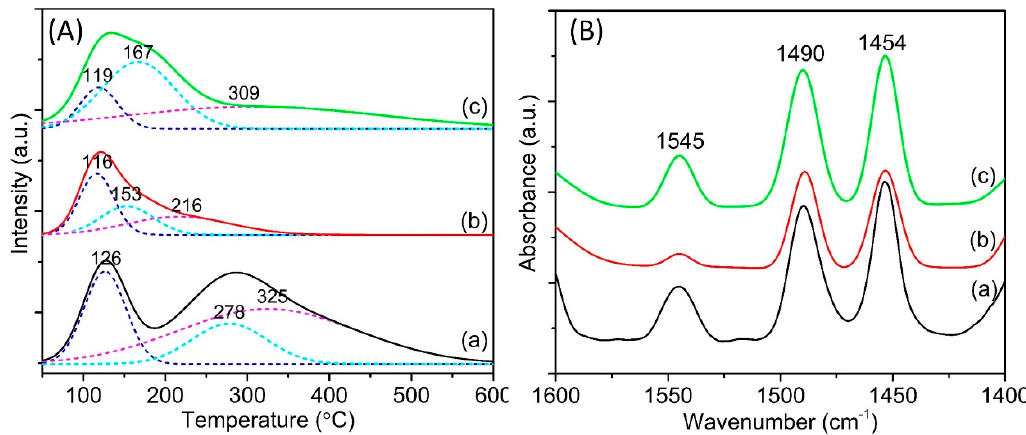
Figure 4. ( A ) TPD-NH 3 profiles and ( B ) pyridine-FTIR spectra of (a) Parent Y65, (b) IM-Y65, and (c)